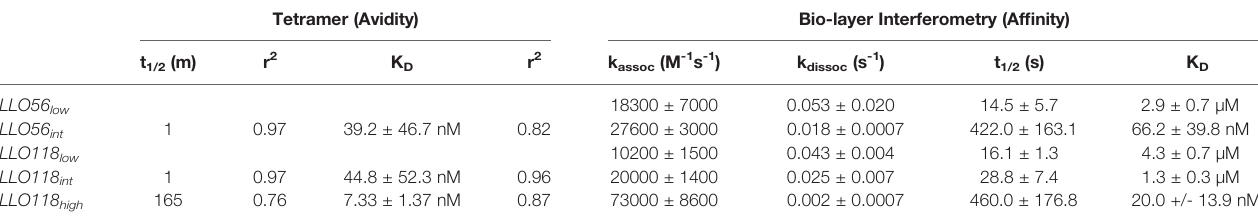
TABLE 1 | Comparison between scTCR clones avidity (Tetramer) and af fi nity K d (Bio-layer Interferometry). Tetramer (Avidity) Bio-layer Interferometry (Af fi